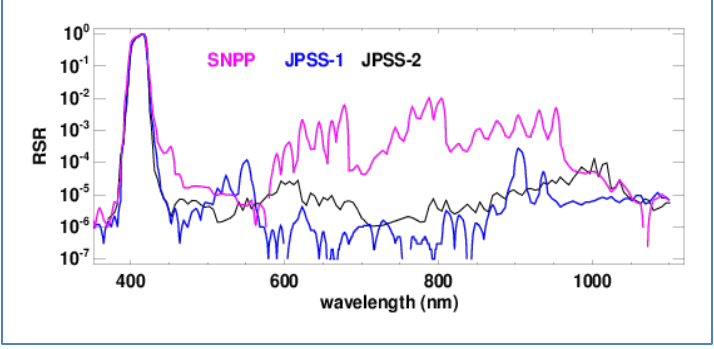
Figure 5. Relative spectral response (RSR) of VIIRS band M1 (S-NPP, JPSS-1, and JPSS-2).